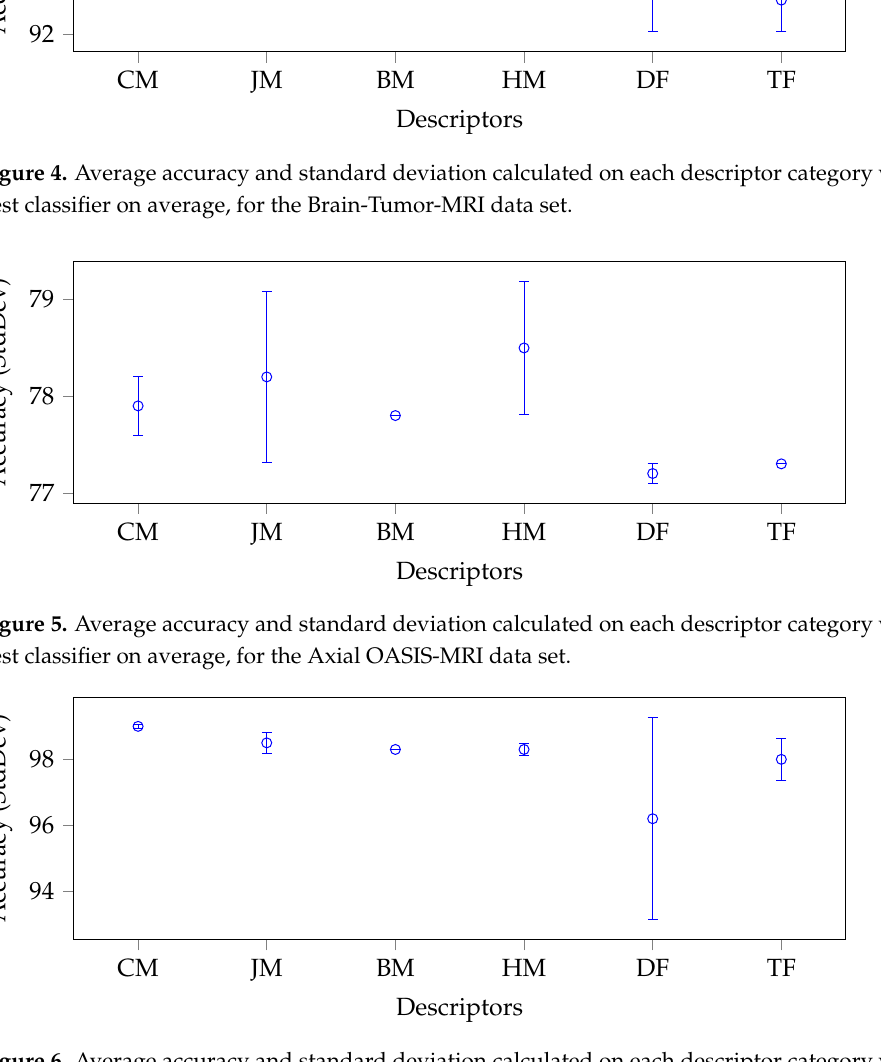
Figure 6. Average accuracy and standard deviation calculated on each descriptor category with the best classifier on average, for the COVIDx CT-2A data